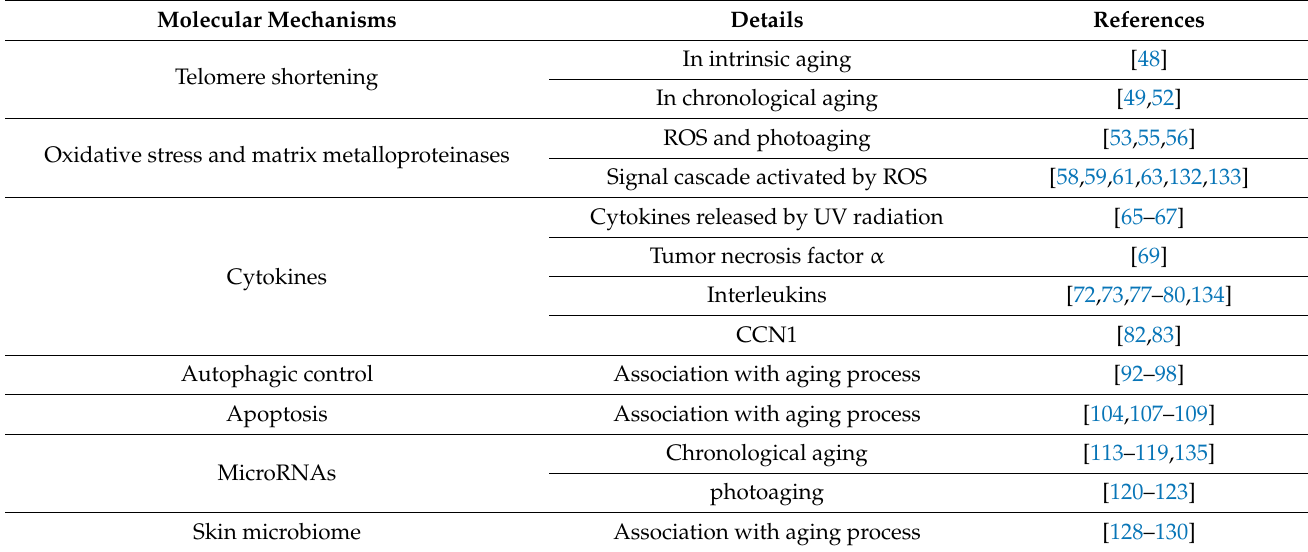
Table 2. Molecular mechanisms of skin aging. ROS, reactive oxygen species; UV, ultraviolet ray, CCN1; Cellular Communi- cation Network Factor